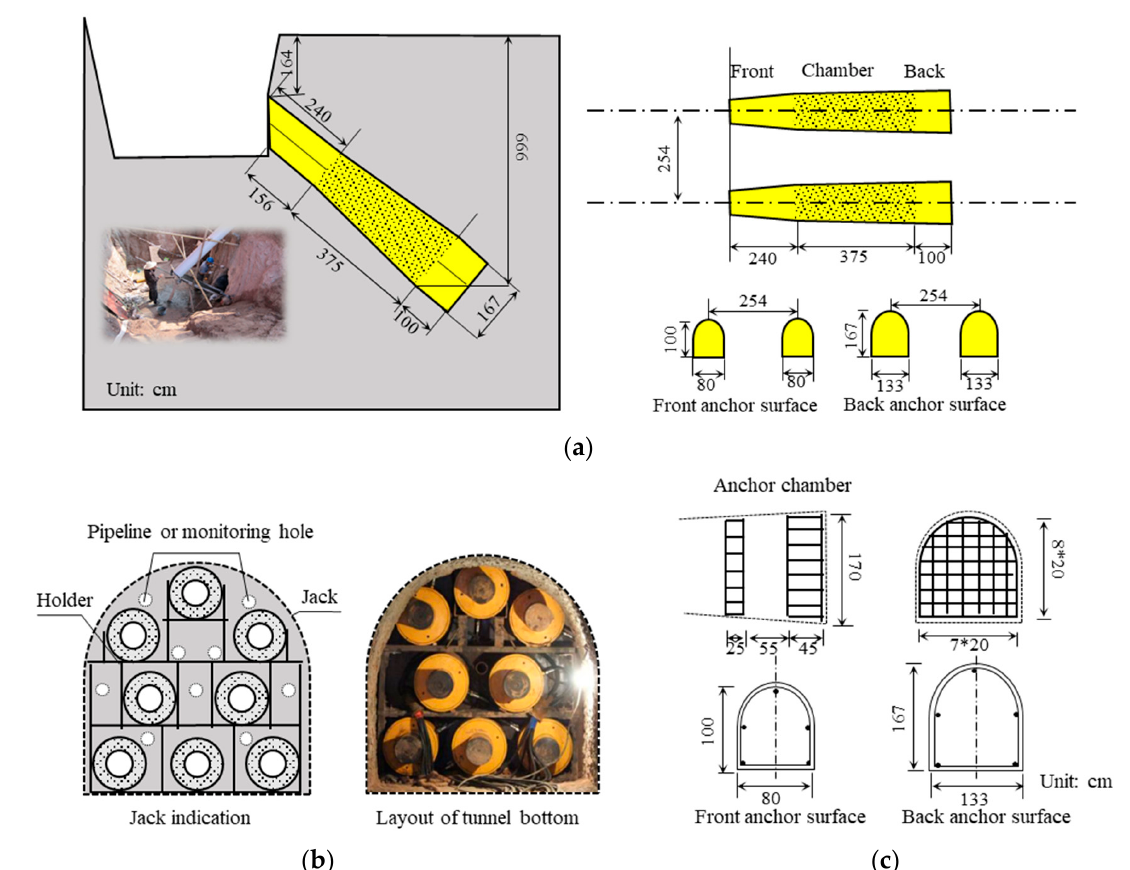
Figure 3. Schematic diagram of the scaled-down model: ( a ) the size; ( b ) the model jack; ( c ) anchor room and jack bottom plate reinforcement.